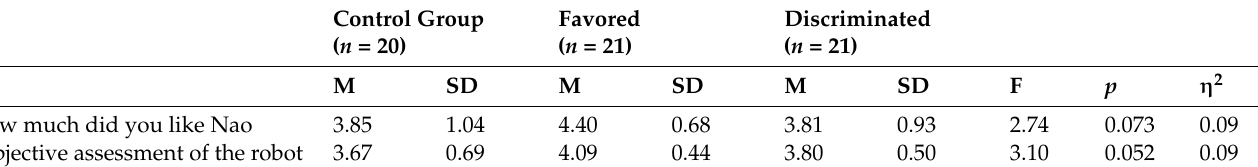
Table 3. Differences in the robot’s likeability and participant’s assessment of the robot.